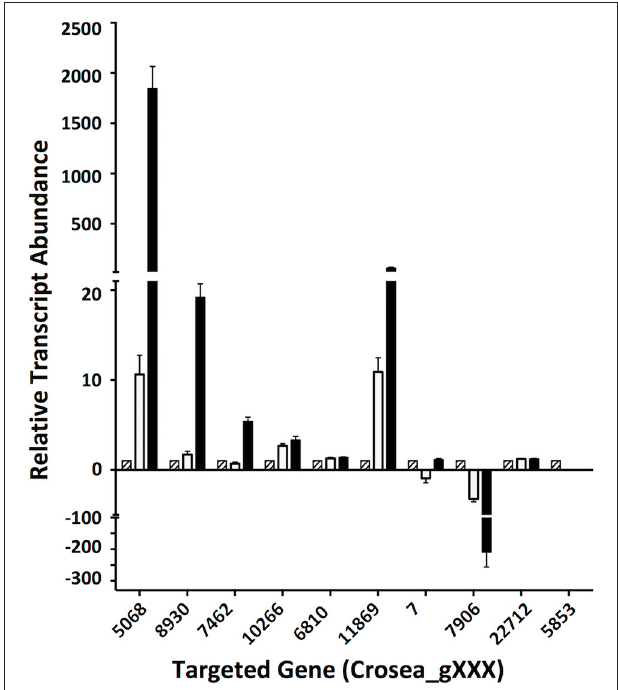
FIGURE 5 | Validation of differentially regulated AMC941 C. rosea transcripts using RT-qPCR. Crosea_g5068: polyketide synthase; Crosea_g8930: multidrug resistance transporter-1, Crosea_g7462: multidrug resistance transporter-4; Crosea_g10266: multidrug resistance transporter-3; Crosea_g6810: multidrug resistance transporter-2; Crosea_g11869: sulfate permease, Crosea_g7: Hydrolase; Crosea_g7906: sterol methyltransferase; Crosea_g22712: pleiotropic drug resistance transporter; Crosea_g5853: Cytochrome p450. Black bars represent the data obtained for the F. graminearum spent-media treated samples, white bars represent the data obtained for the DON-treated samples and the hatched bars represent the data obtained for the MeOH-treated samples. Error bars indicate standard error ( n =